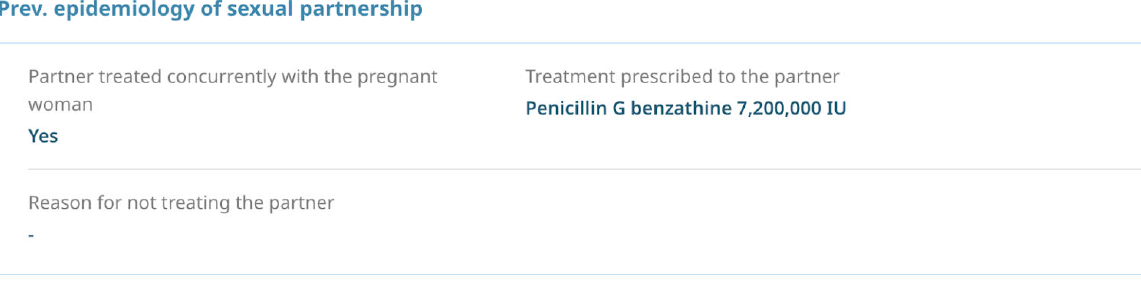
Figure A7. Partner treatment follow-up.